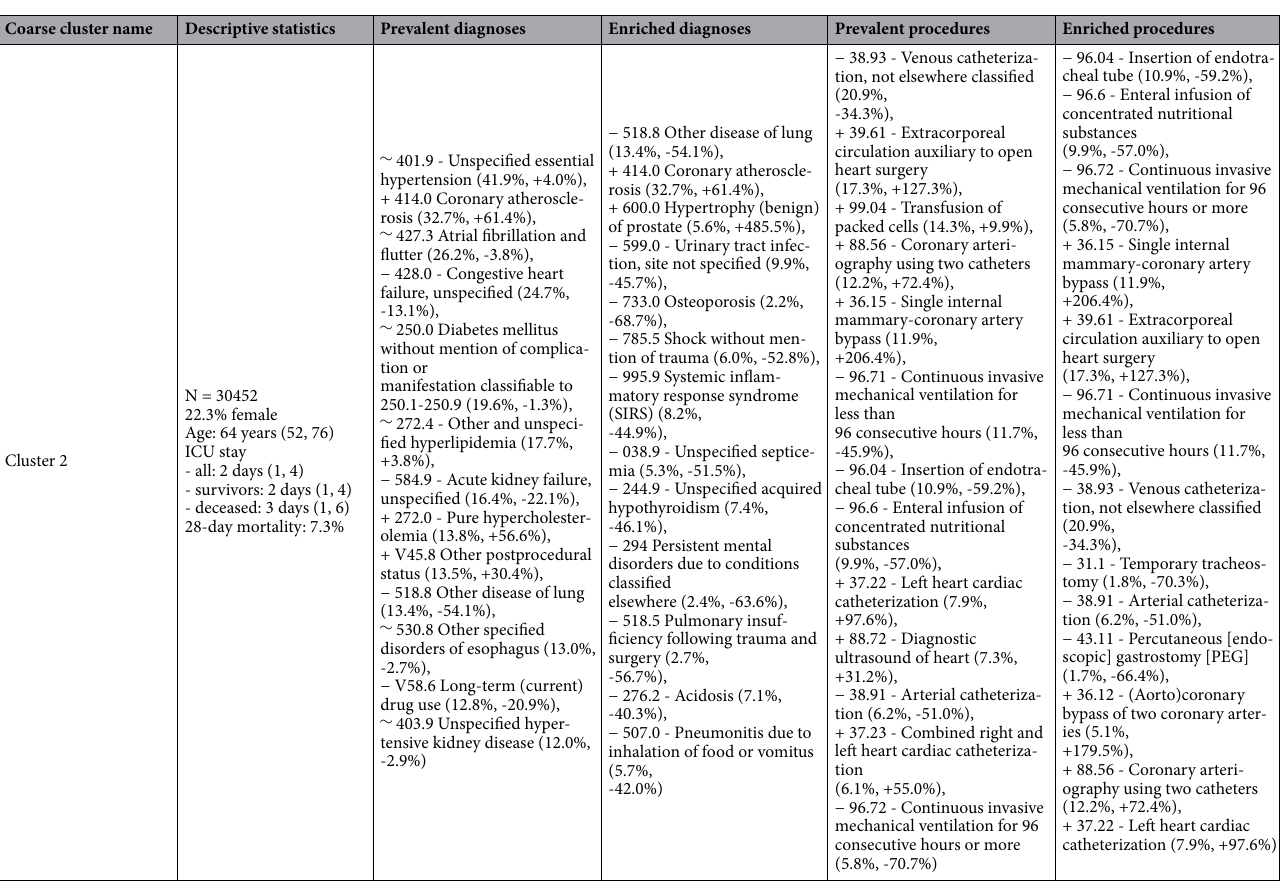
Table 1. Coarse clustering results. We show basic descriptive statistics of the two clusters as well as the population. Frequent ICD-9 diagnoses or procedures are shown if they are enriched within a cluster (“+” for positively enriched, “−” for negatively enriched) and are sorted by the degree of enrichment within the cluster from high to low. “Prevalent” codes are sorted by the prevalence. Note that often, negatively enriched codes can be just as important in understanding a cluster as positively enriched codes. After each code, we show its support within the cluster (i.e. the fraction of admissions within the cluster that exhibit all diagnoses in the itemset) and the ratio between support in the cluster and support in the complement. Distributions of frequent ICD-9 codes vary between clusters. While patients in Cluster 1 suffer from acute conditions (lung diseases, heart failure, acute kidney failure, septicemia) more often, patients in Cluster 2 are more likely to exhibit chronic conditions. Additionally, differences between the clusters in terms of age and sex distribution, length of ICU stay, and mortality can be observed. Apart from age and sex, none of this data is supplied as input to our model. Thus, it follows these differences stem from information captured in the learned feature